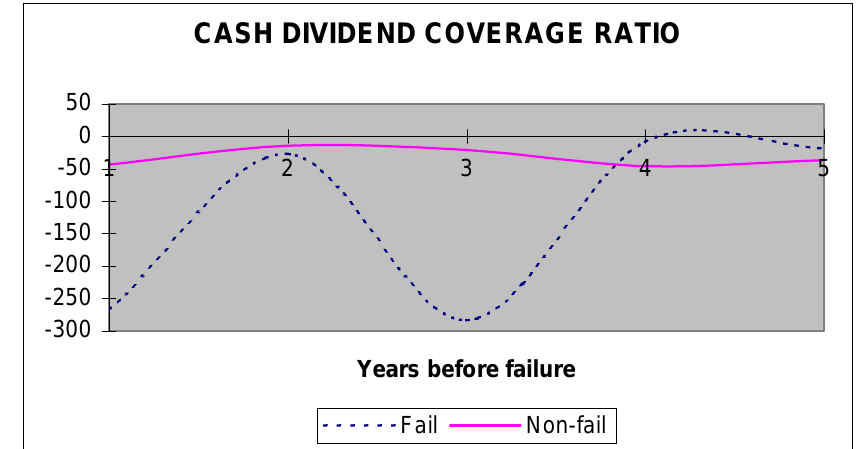
Figure 7: Cash dividend coverage ratio CASH DIVIDEND COVERAGE